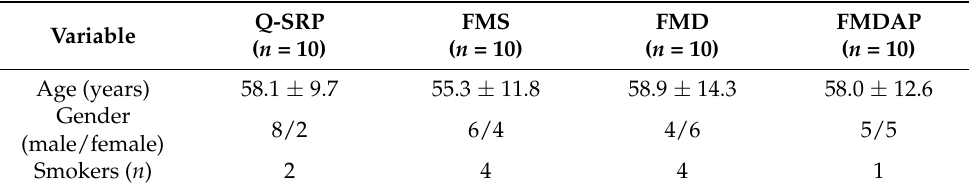
Table 1. Patient data recorded at the baseline examination.